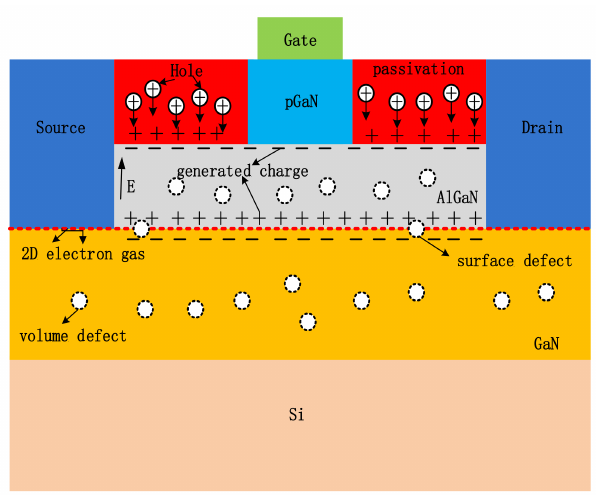
Figure 8. Schematic diagram of the electron-hole pairs transport process induced by the interaction of neutrons and gamma-rays in GaN